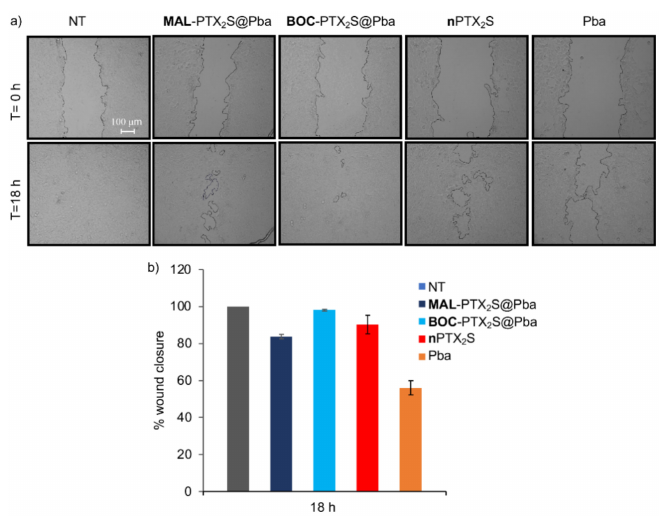
Figure 7. The motility of 4T1 cells was measured by wound healing assay. ( a ) Phase-contrast microscopy images (scale bar: 100 µ m) at the beginning of the experiment (0 h) and at the end point (18 h). ( b ) Graph representing the percentage of wound